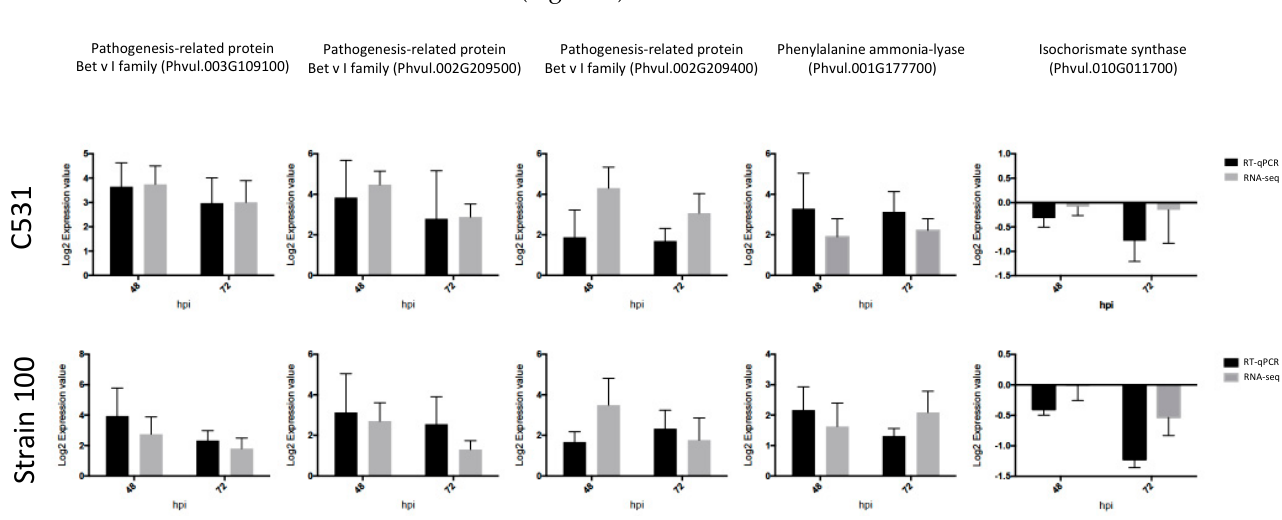
Figure 7. Validation of RNA-seq results by RT-qPCR in BAT93 plants in response to inoculation with C. lindemuthianum. Expression data were normalized using two housekeeping genes ( Act and UBI ) and calibrated relative to Mock.